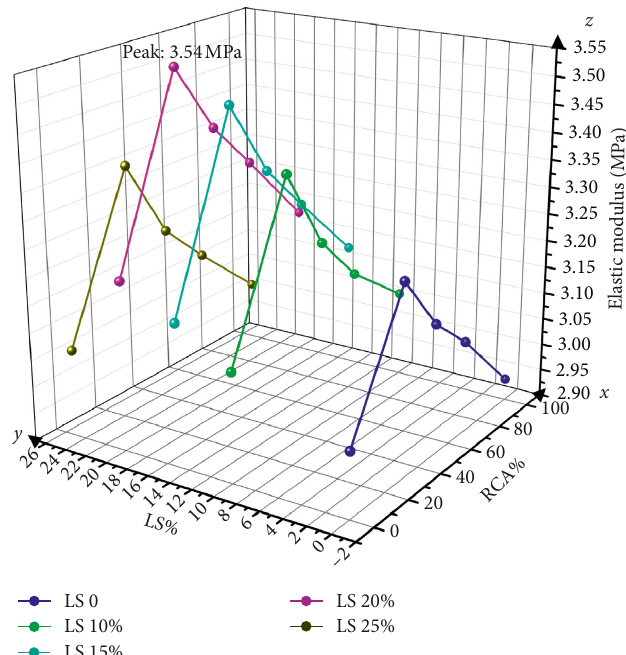
Figure 6: The effect of RCA and LS on the elastic